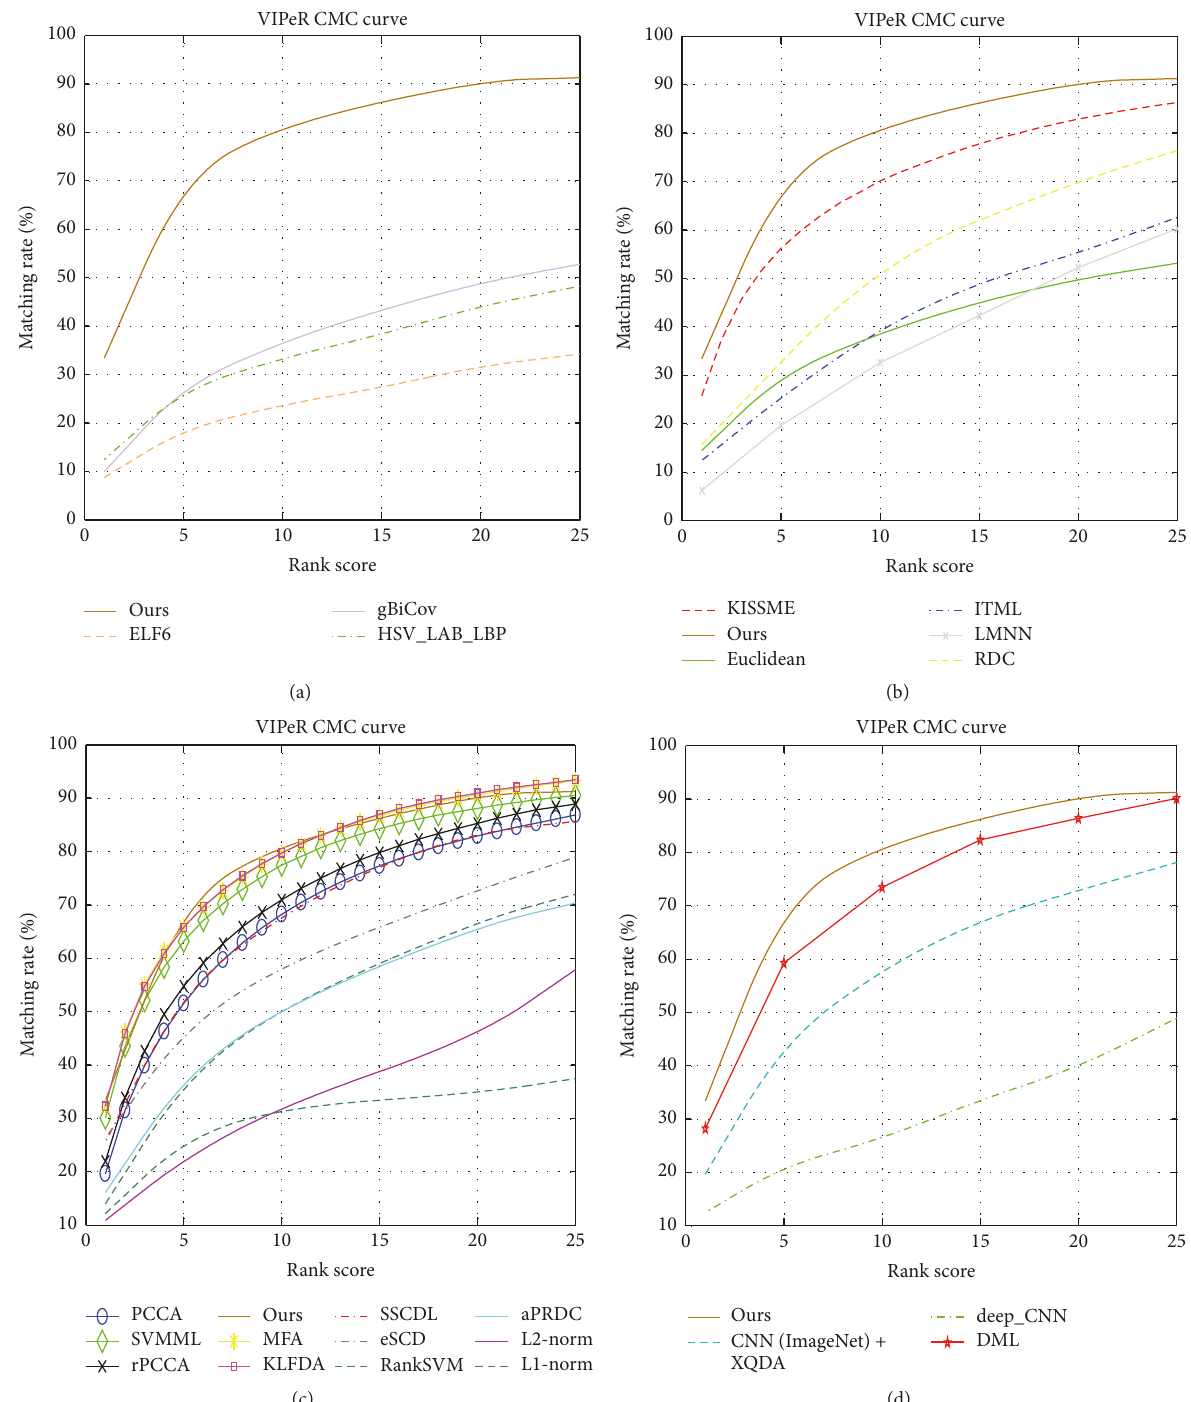
Figure 4: CMC curves on VIPeR data set. (a) Performance comparison with feature representation algorithms; (b) performance comparison with metric learning algorithms; (c) performance comparison with other state-of-the-art algorithms; (d) performance comparison with other CNN-based